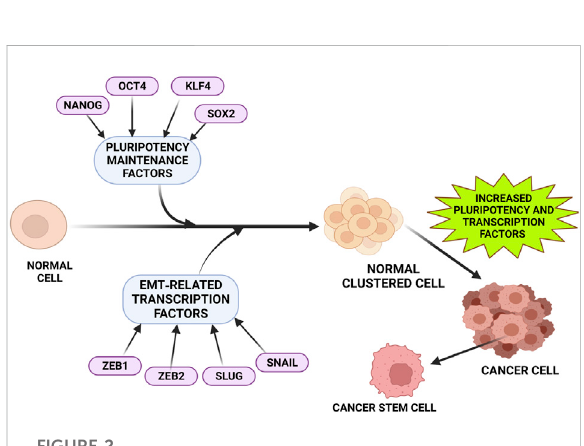
FIGURE 2 Factors that upregulates DCLK1 expression in cancer. Tumor progression and metastasis are often observed to be associated closely with increased pluripotent maintenance factors and EMT-related transcription factors. An increase in these factors leadstothetransitionofnormalcellsintocancercellswithincreased stemness property and elevated DCLK1 expression. The pluripotent maintenance factors and EMT factors regulate DCLK1 expression in cancer